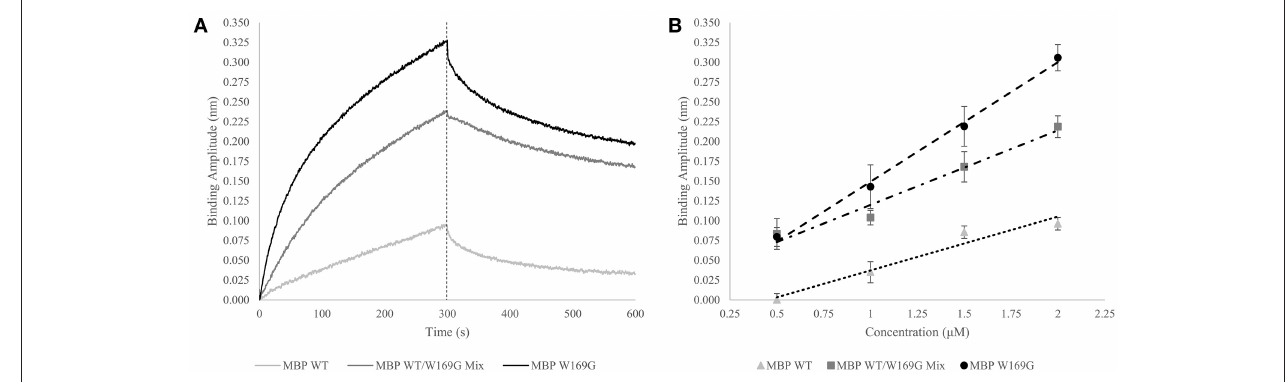
FIGURE 3 | Wild- vs. Mutant-Type MBP Capture by GroEL Biosensor. (A) Raw biosensor traces at 2 µ M for wild-type (light gray), W169G (black), and the mixed population (dark gray). The dotted line indicates the end of association, which is the amplitudes used for the linear response. (B) Linear response of wild-type and destabilized mutant-type MBP capture versus concentration (triangles and circles, respectively). For pure protein population, the x-axis is absolute concentration. Dose-dependent response of doping mutant-type MBP into wild-type is shown in squares. For the protein mixtures, the x-axis value is the concentration of mutant-type added to a solution containing 0.5 µ M wild-type. R-squared values for the wild-type, W169G, and mixture are 0.964, 0.996, and 0.961, respectively. The Z’ factor for wild-type versus mutant-type response at 2 µ M is 0.649, which indicates the response of this system is reliable to develop an assay that can distinguish between mixtures and homogenous